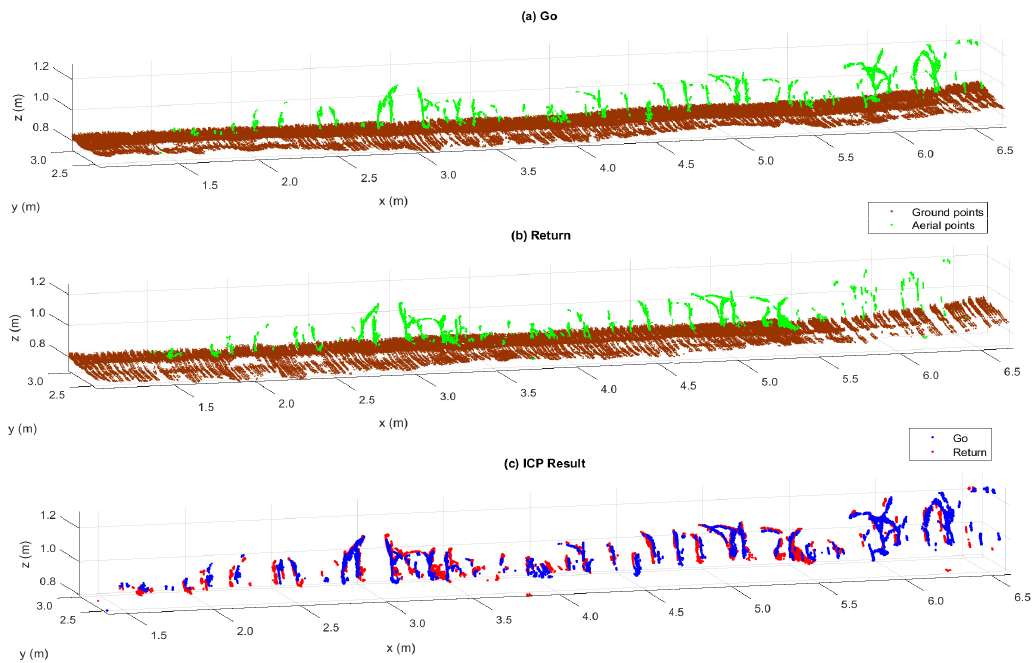
Figure 9. ( a ) RANSAC go results; ( b ) RANSAC return results; and ( c ) ICP result of the aerial point clouds for the vertical LiDAR’s orientation when going and returning at path 1 and row 2.